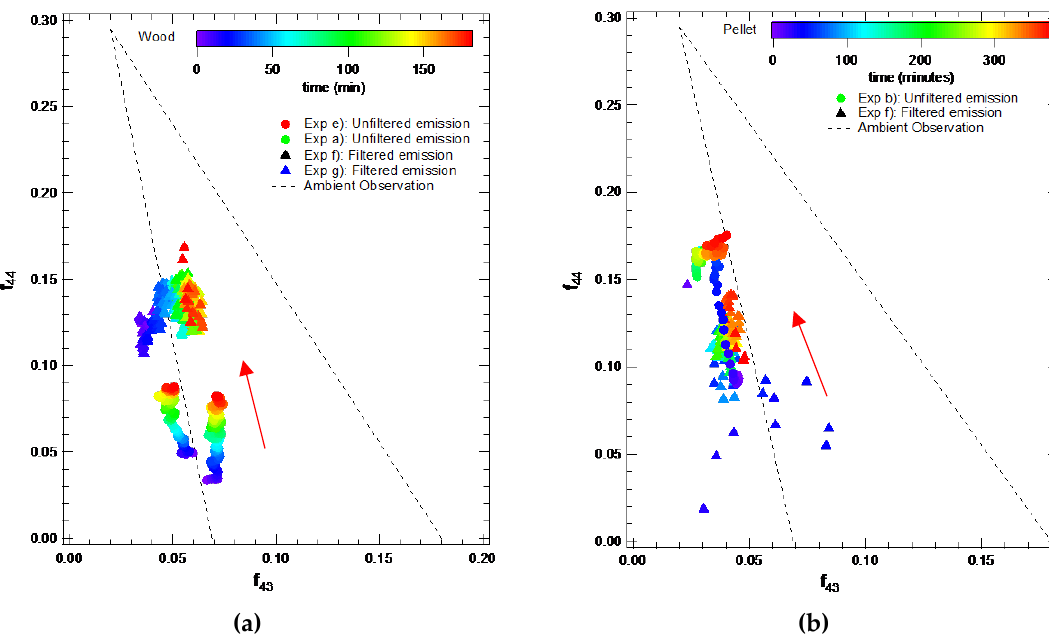
Figure 8. ( a ) f 44 (dominated by the CO 2 + ion) vs. f 43 (dominated by primary organic aerosols (POA)) for all wood experiments ( b ) for pellet experiments. The evolution with time of the factors is shown with the red arrow